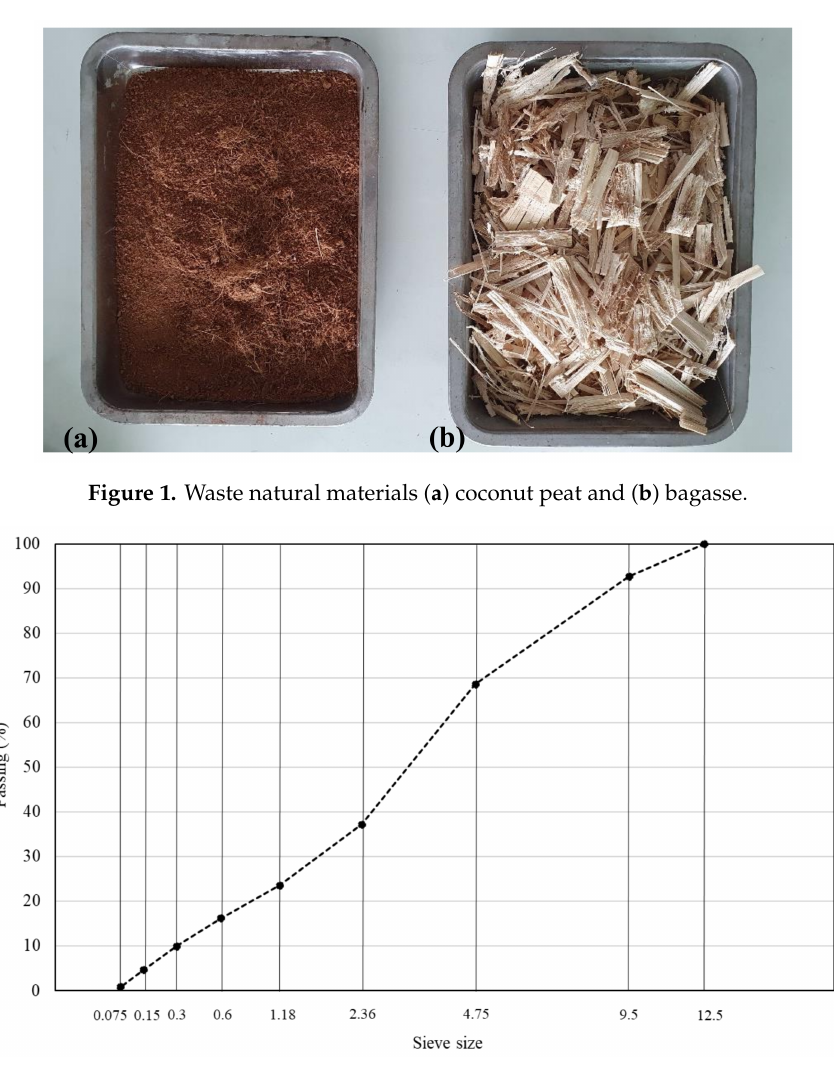
Figure 2. Aggregate